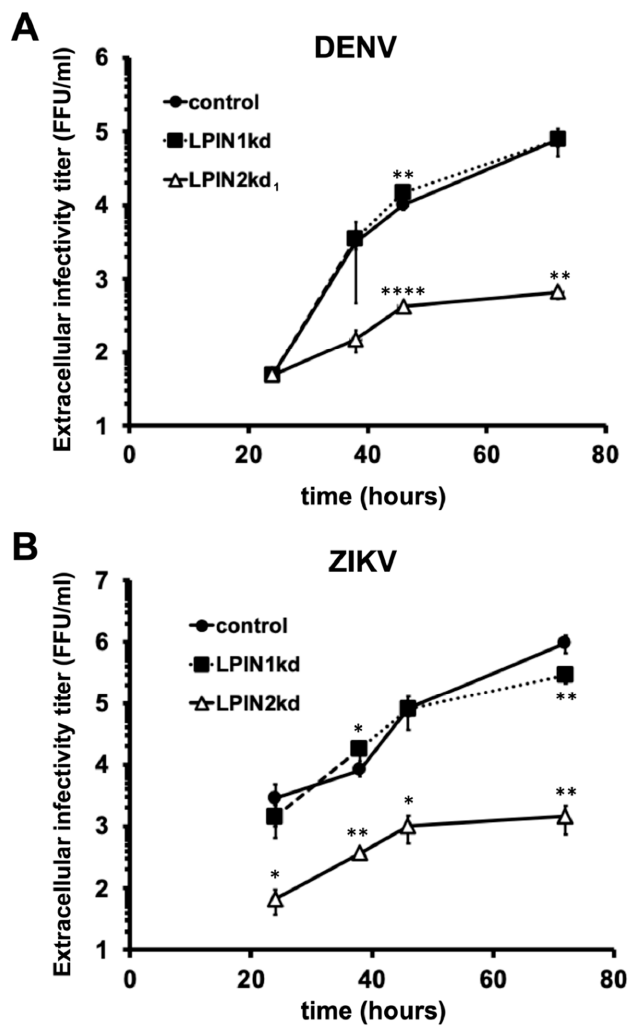
Figure 7. Lipin2, but not lipin1, silencing interferes with DENV and ZIKV virus propagation. Huh-7 cells were transduced with lentiviral vectors expressing non-targeting (control), shRNAs targeting LPIN1 (LPIN1kd) or LPIN2 mRNA (LPIN2kd 1 and LPIN2kd 2 ). At day 7 post transduction, the different cultures were inoculated with DENV (NGC strain), with ZIKV (BeH819015 strain). Samples of the cell supernatants collected at the indicated time points were used to determine extracellular infectivity titers. ( A ) DENV and ( B ) ZIKV extracellular infectivity titers. Data are shown as average and SD of three biological replicates ( n = 3) from one experiment. Statistical significance was evaluated using one ‐ way ANOVA and Dunnet´s post hoc test. (* p < 0.05; ** p < 0.01; **** p < 0.001). These results suggest that, in contrast to lipin1, cellular alterations induced by lipin2 silencing limit replication by all tested viruses, underscoring the notion that lipin1 and lipin2 may play different roles in Huh ‐ 7 cells. This is further supported by the fact that increased lipin1 accumulation could not functionally compensate lipin2 deficiency to support HCV infection and vice versa (Figure 1) and [29].